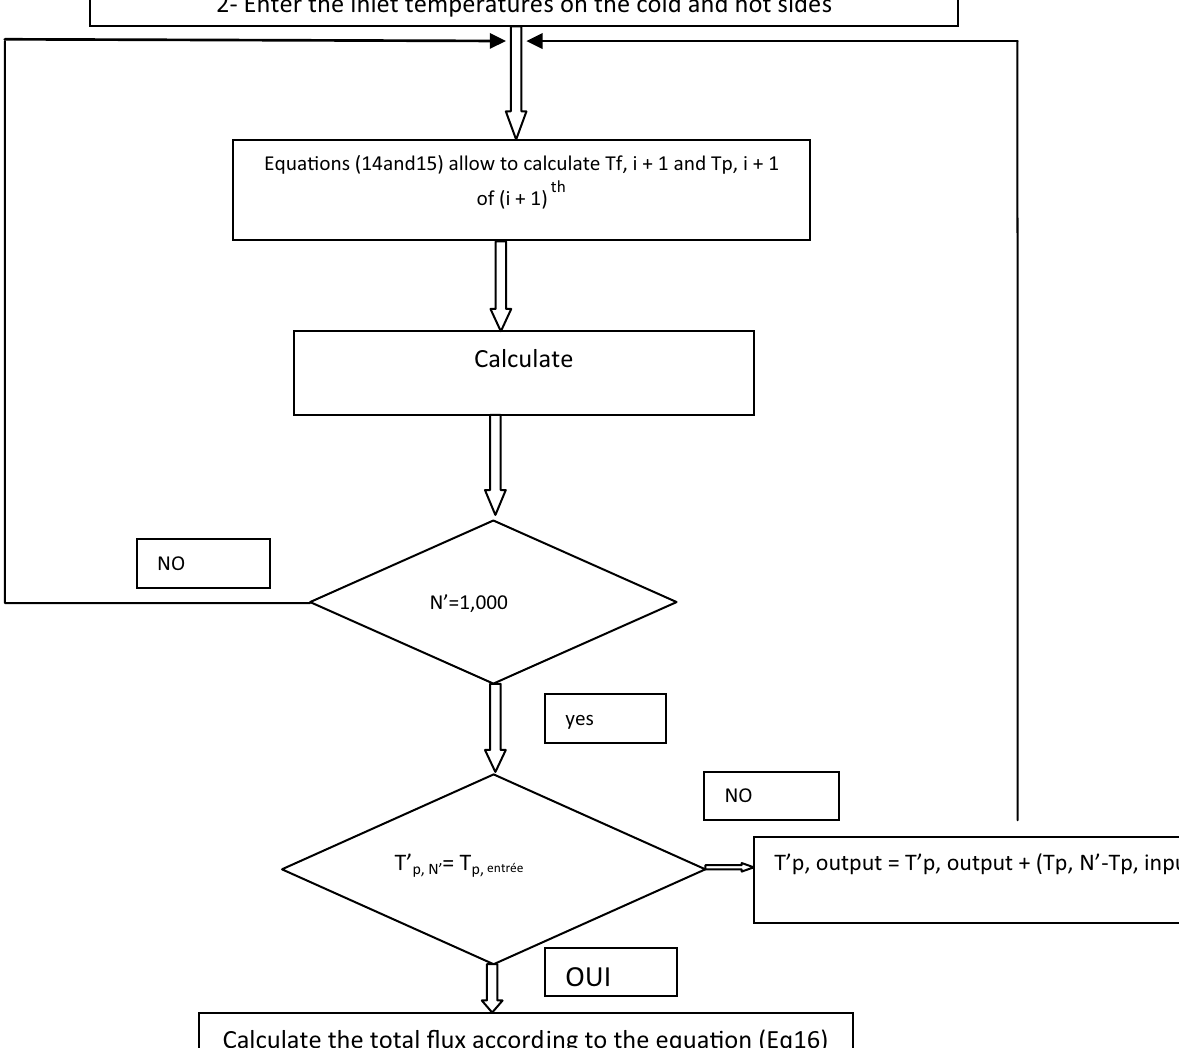
Fig. 9 An algorithm for SGMD simulation